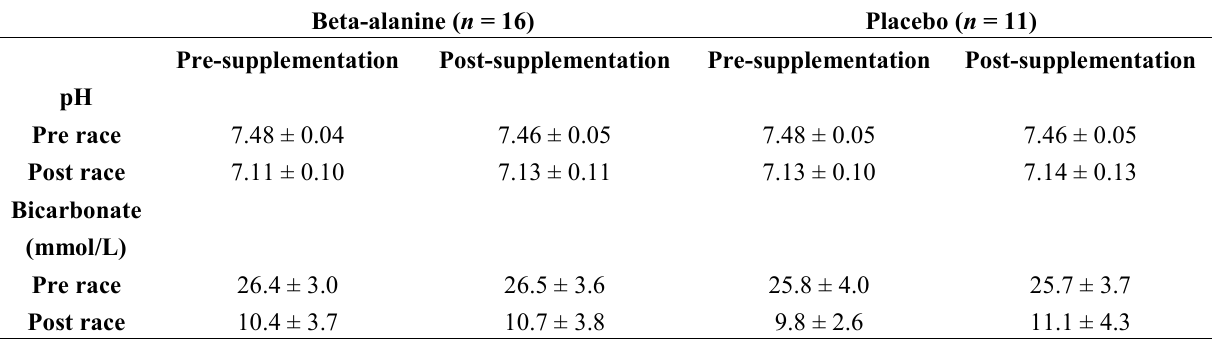
Table 2. Unclear effects of beta-alanine (BA) supplementation on pre and post race blood pH and bicarbonate values between the pre- and post-supplementation competitions. A total of 27 blood samples were analyzed on both pre and post tests.